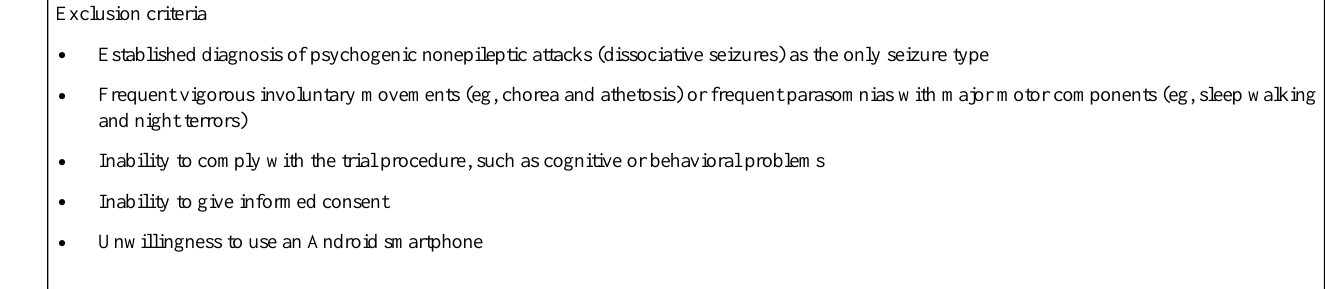
Textbox 2. Exclusion